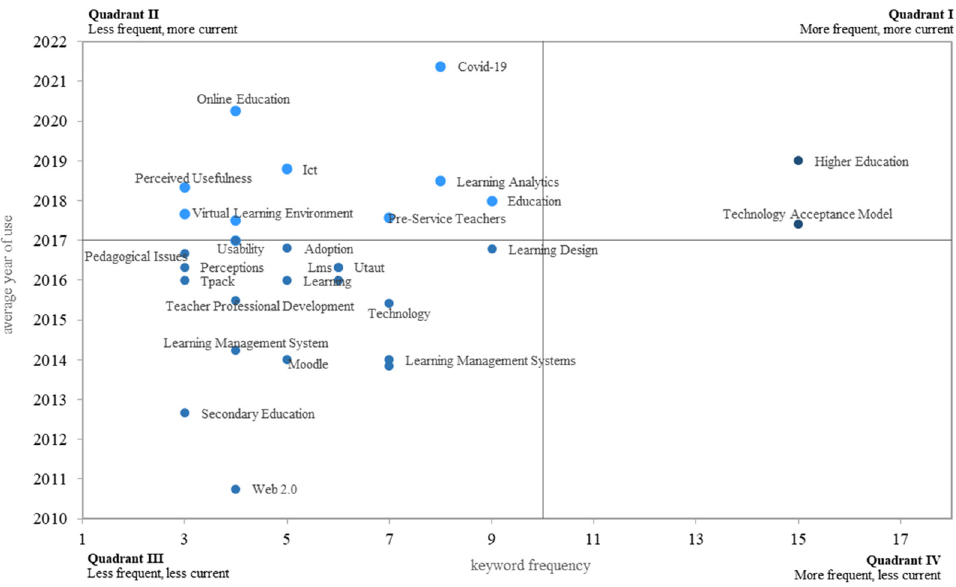
Figure 11. Keyword validity and frequency. Own elaboration.